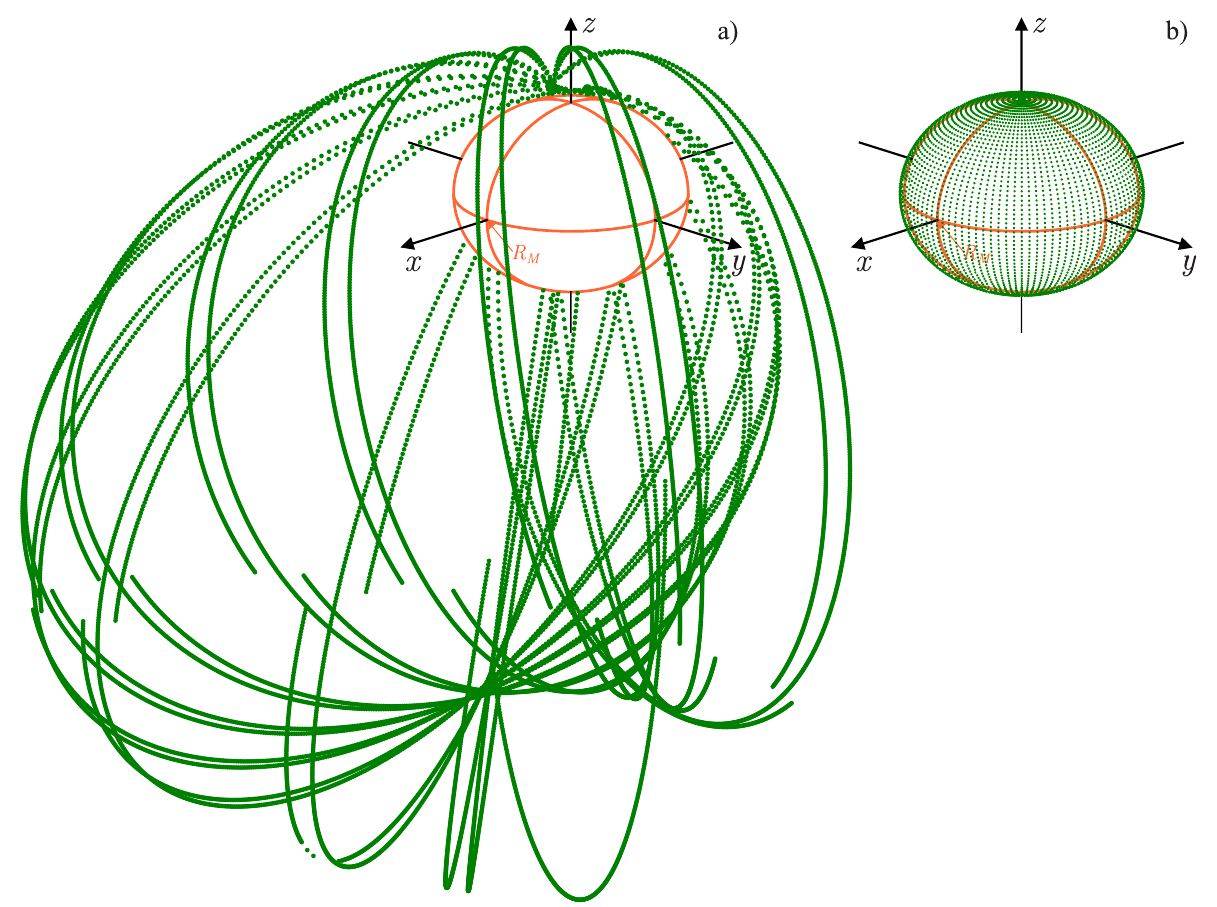
Figure 1. ( a ) The location relative to Mercury of the magnetic field measurement points r s by the MESSENGER mission; ( b ) location of points in a thin spherical layer where the magnetic field was recalculated. R M is the average radius of Mercury, R M = 2,439,700